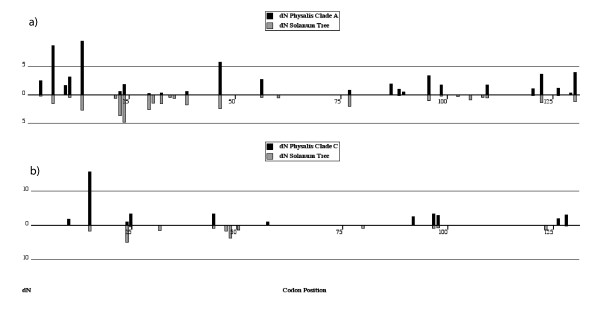
a) The FEL Clade analysis indicated the 18 codons from Physalis Clade A (see Figure 1) that have significantly greater dN/dS values using LRT's and p-values ≤ 0.05 and the 10 sites estimated to have greater dN/dS in Solanum (sites listed in Table 3). b) Physalis Clade C shows 9 positively selected Physalis sites with only 2 overlapping with Clade A (see also Table 3). Under this model 7 Solanum sites show higher dN/dS. The majority of sites favoring greater positive selection in Solanum are found in the HVa and HVb regions. Only dN values are reported for Clades A and C (black bars) and Solanum (gray bars) as dS values are shared across genera.